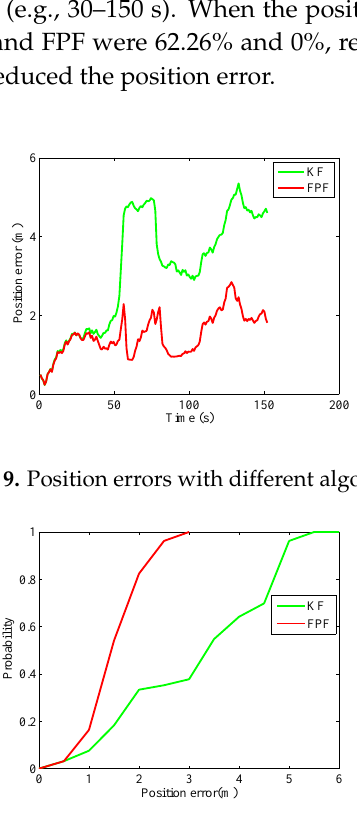
Figure 10. CDF with different